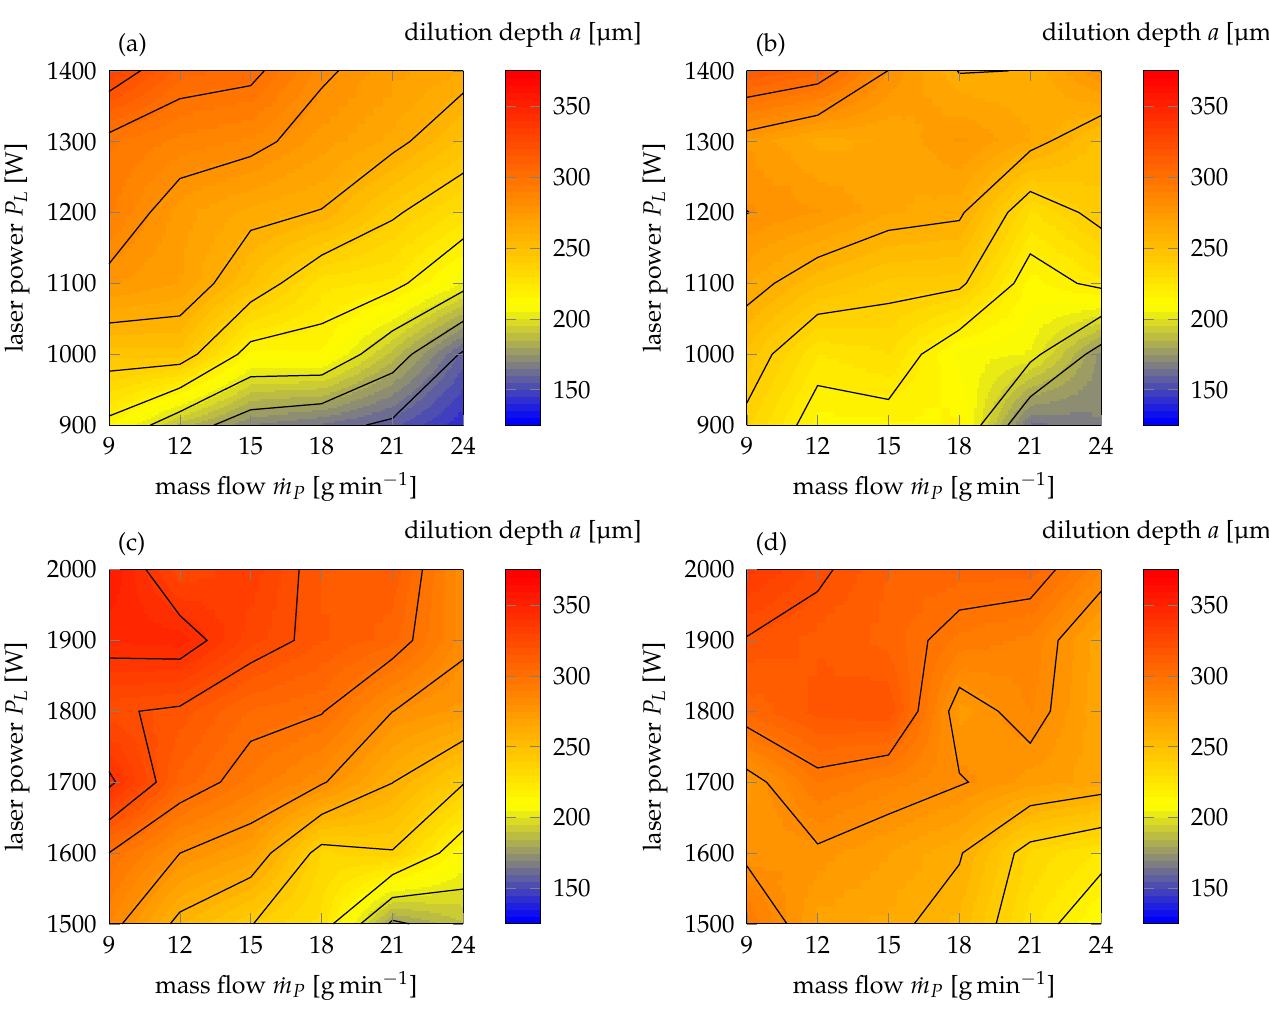
Figure 7. Development of dilution depth a in dependence on laser power P L and mass flow ˙ m P . Top: laser beam diameter 800µm, bottom: laser beam diameter d L d L ≈